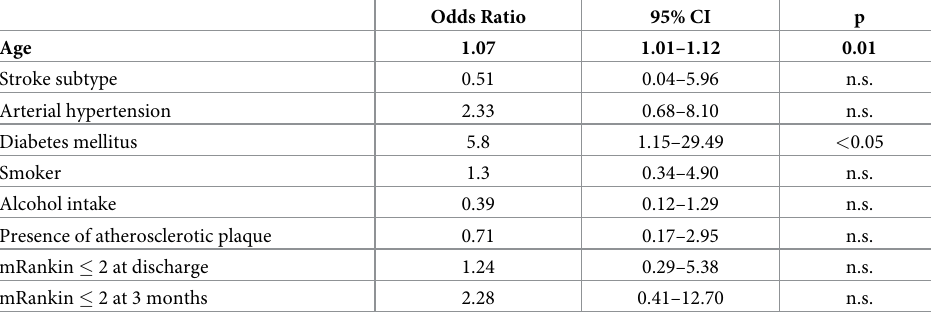
Table 2. Adjusted odds ratios of ELC for significant clinical variables in bivariate analysis.